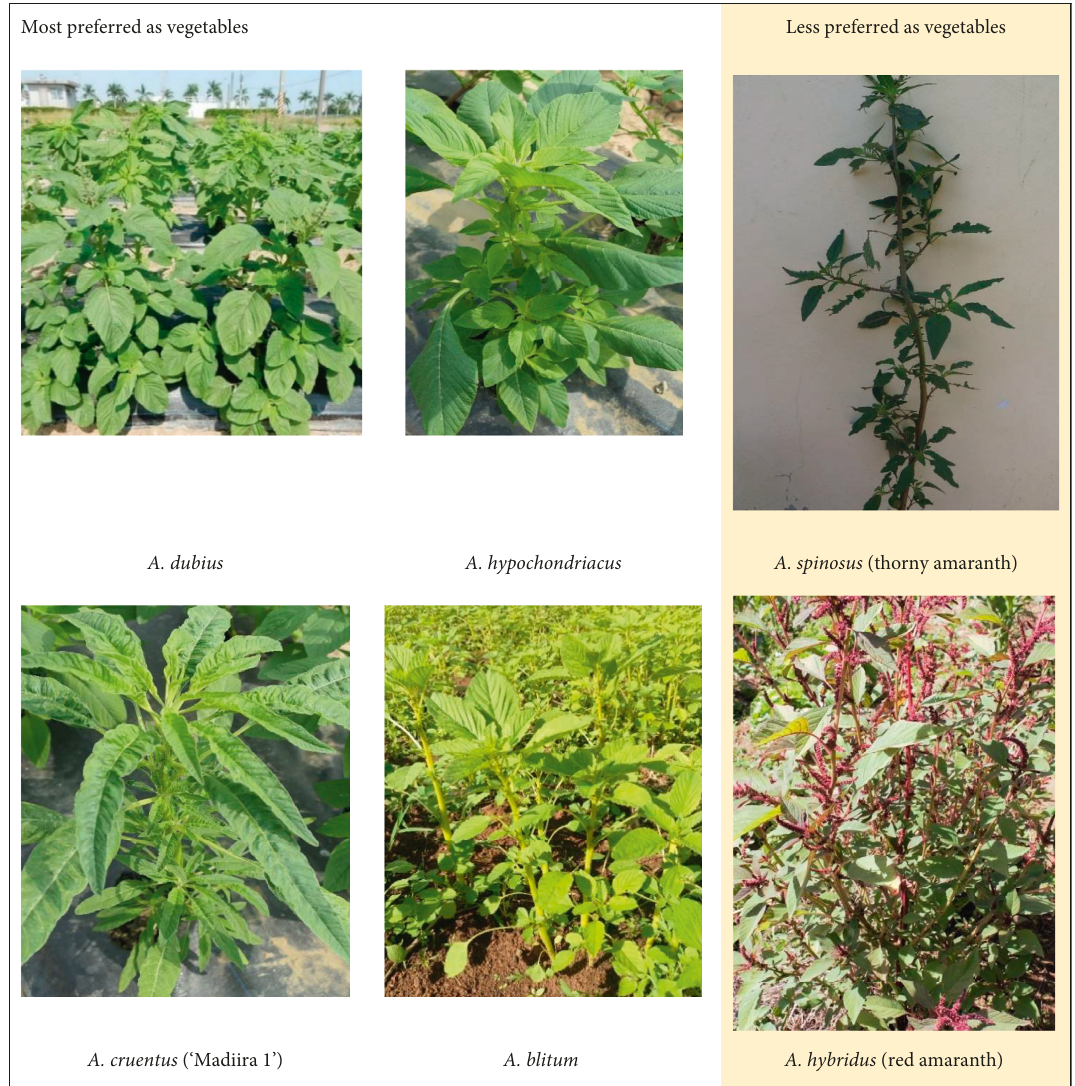
Figure 3: Pictures of the common amaranth